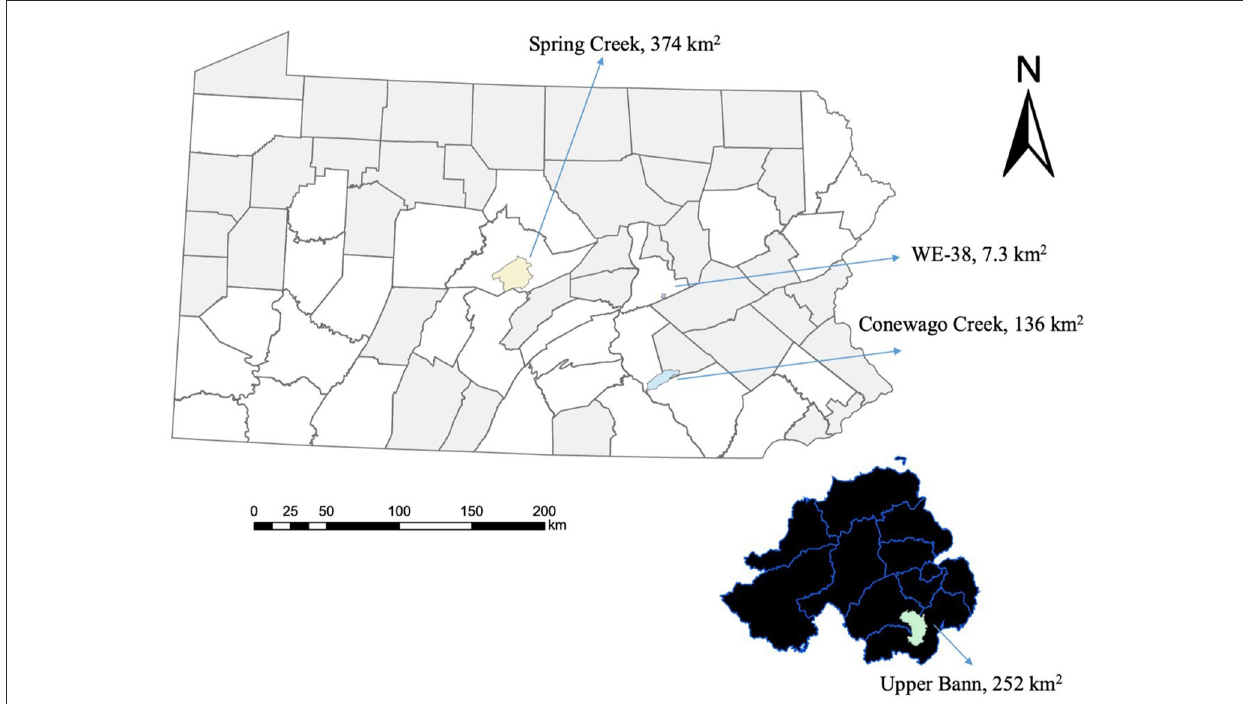
FIGURE1 Respective land area for Spring Creek and Conewago Creek (part of the Chesapeake Bay watershed) as compared to the Upper